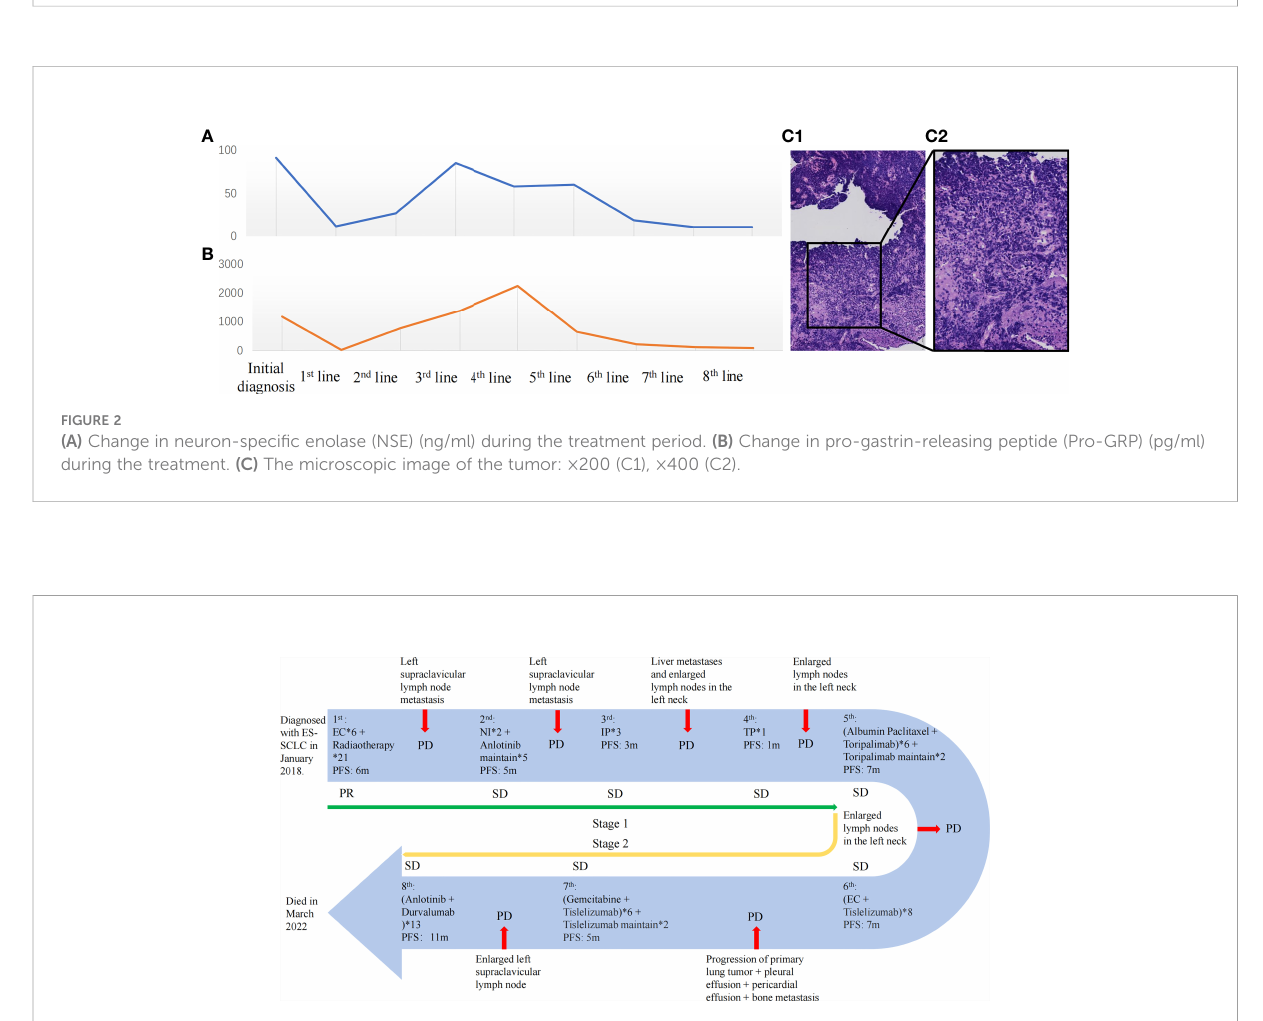
FIGURE 3 The treatment progress of the patient. The fi rst stage includes the fi rst to fourth lines of treatment; the fi fth to eighth lines of treatment are the second stage. PR, partial response; PD, progressive disease; SD, stable disease. The ef fi cacy evaluation was judged according to the Response Evaluation Criteria in Solid Tumours (RECIST) (Version